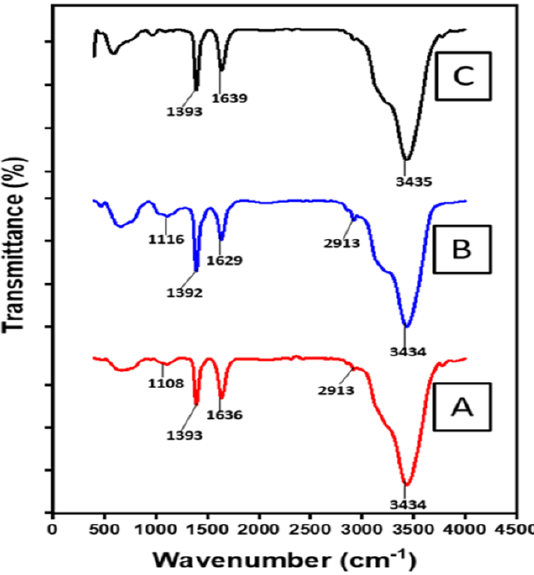
Figure 8. FT-IR spectra of deposited CNTs: ( A ) CNT 0 , ( B ) CNT X and ( C ) CNT T .